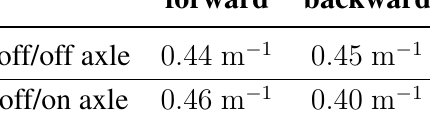
Table 1. Curvature limitation γ trailer